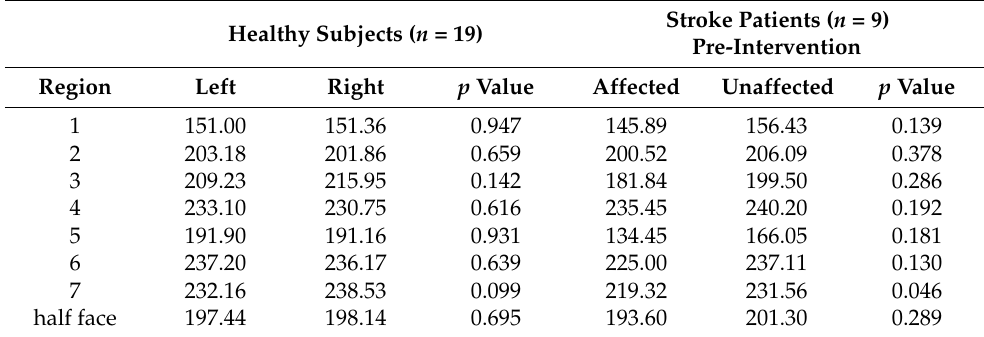
Table 2. The facial skin blood flow between healthy subjects and stroke patients with facial paralysis. Stroke Patients ( n = Healthy Subjects ( n = 19)